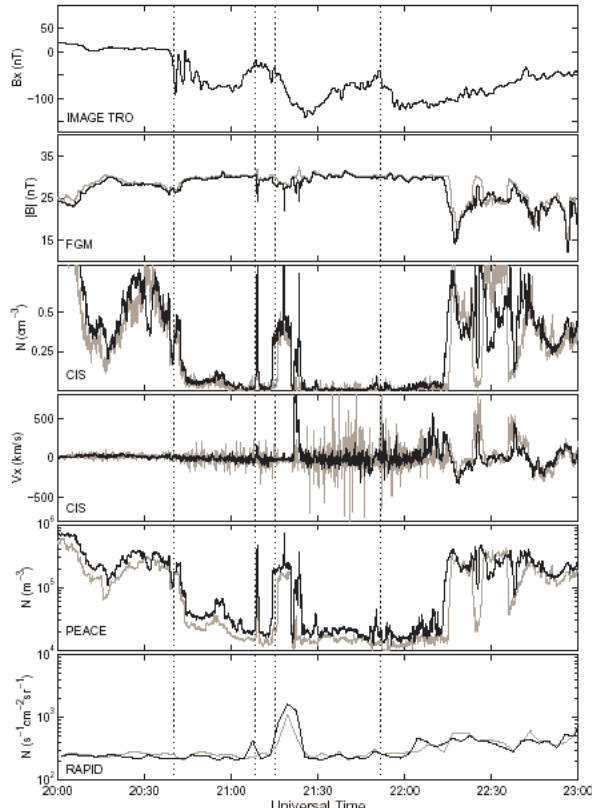
Fig. 17. North component magnetogram from the MIRACLE mag- netometer station Tromsø (TRO) and data from Cluster 3 (gray) and 4 (black). The substorm onset and intensifications have been marked by dashed vertical lines. (From Bor¨alv et al.,